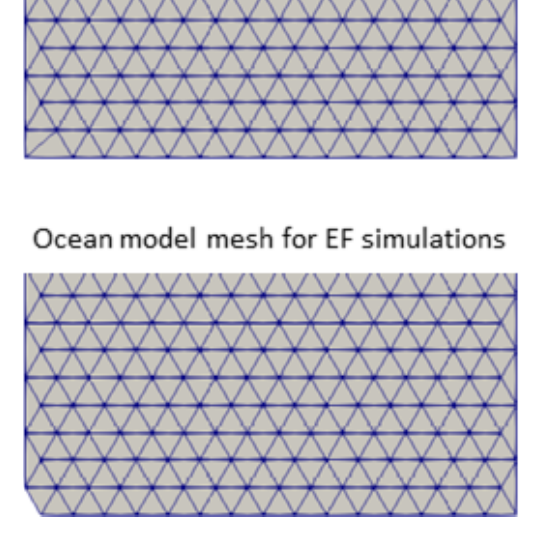
Figure 3. Unstructured meshes used in the current study. The first 15km is shown. The ocean model in the ER simulations uses a structured